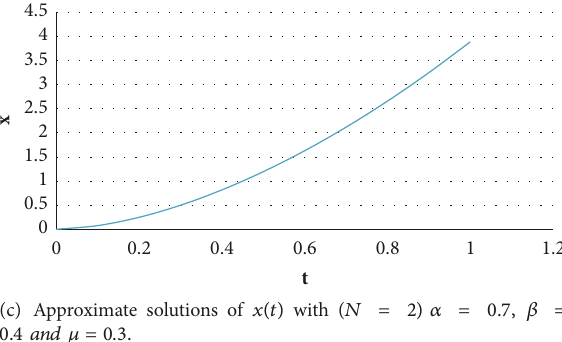
Figure 1: Display the exact and approximate values of state x(t) with different types of 𝛼, 𝛽 , 𝜇 .